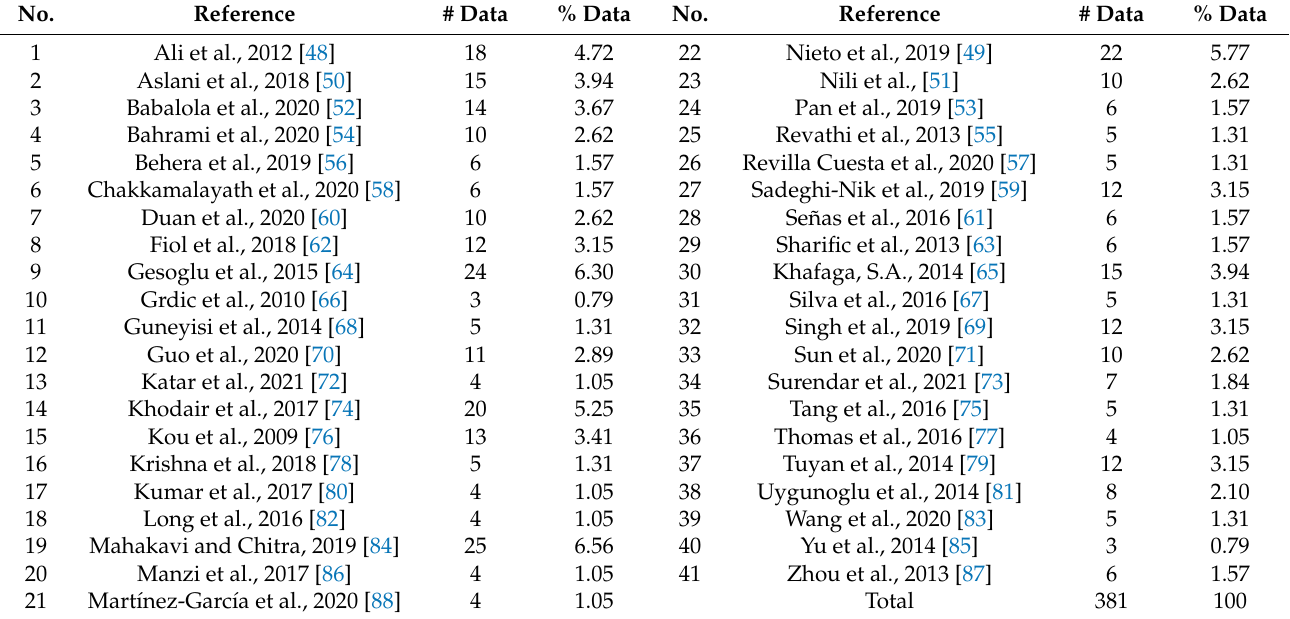
Table 1. Experimental database.